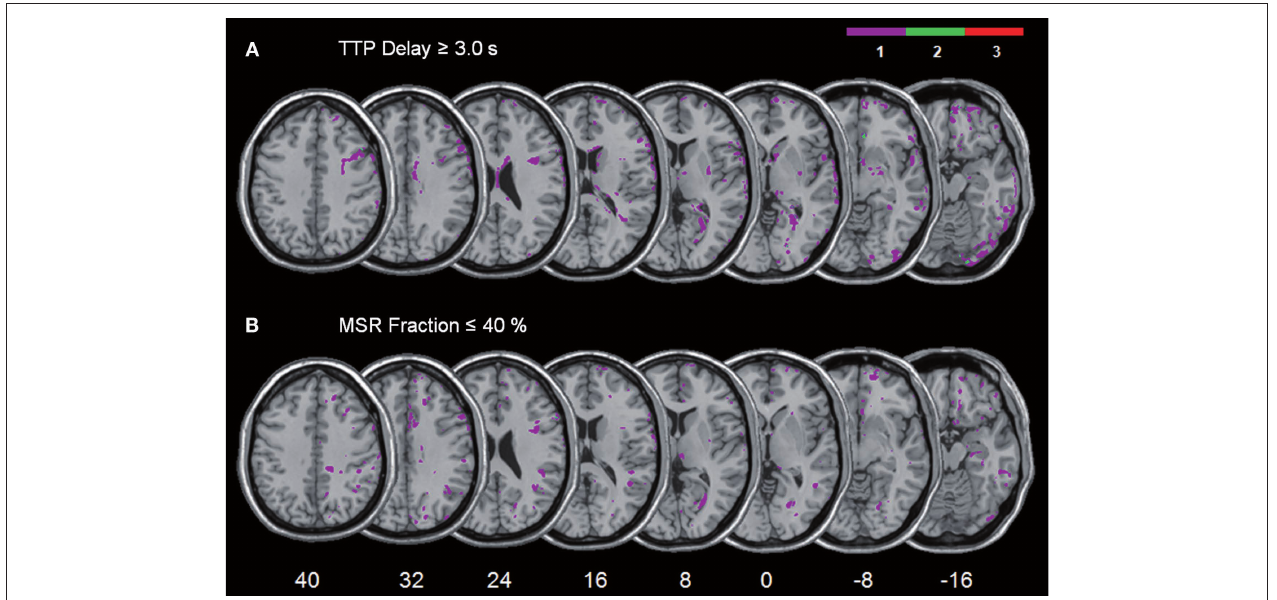
FIGURE 4 | Overlay plots showing the common regions of structurally intact but malperfused brain tissue for the patient group with spatial neglect. (A) The mismatch between TTP ≥ 3.0 s delay maps and DWI/FLAIR. (B) The mismatch